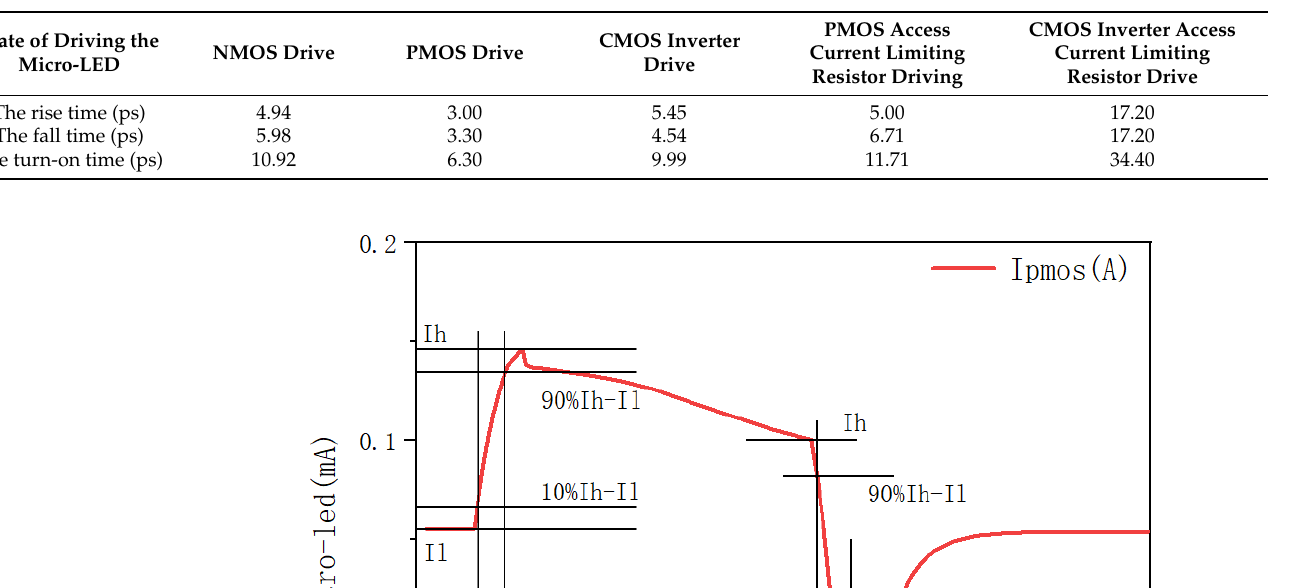
Table 3. Statistics of on/off Times in Different Driving States.